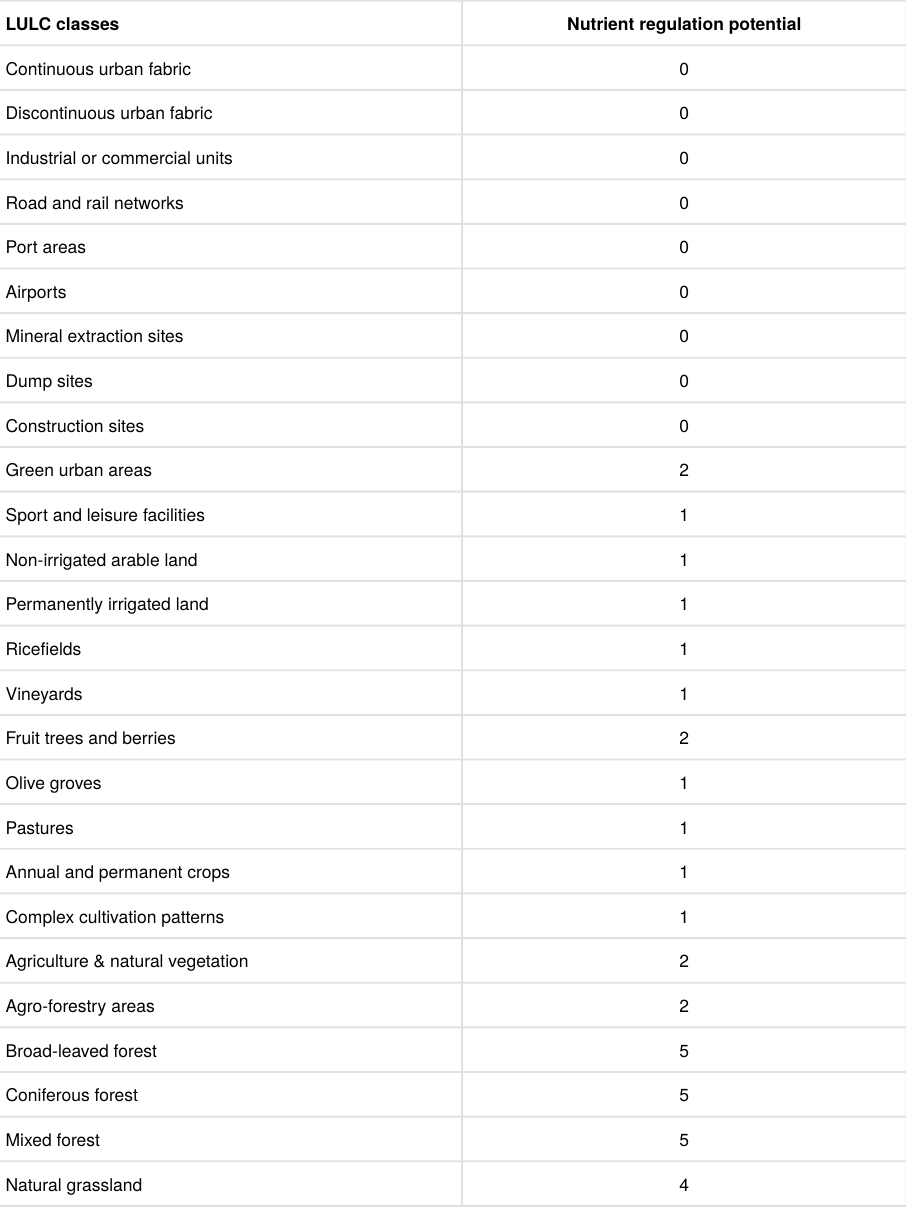
Adopted ecosystem service potential supply values for nutrient regulation. Scale 0 = no relevant potential; 1 = low relevant potential; 2 = relevant potential; 3 = medium relevant potential; 4 = high relevant potential; 5 = very high (maximum) relevant potential (based upon Burkhard et